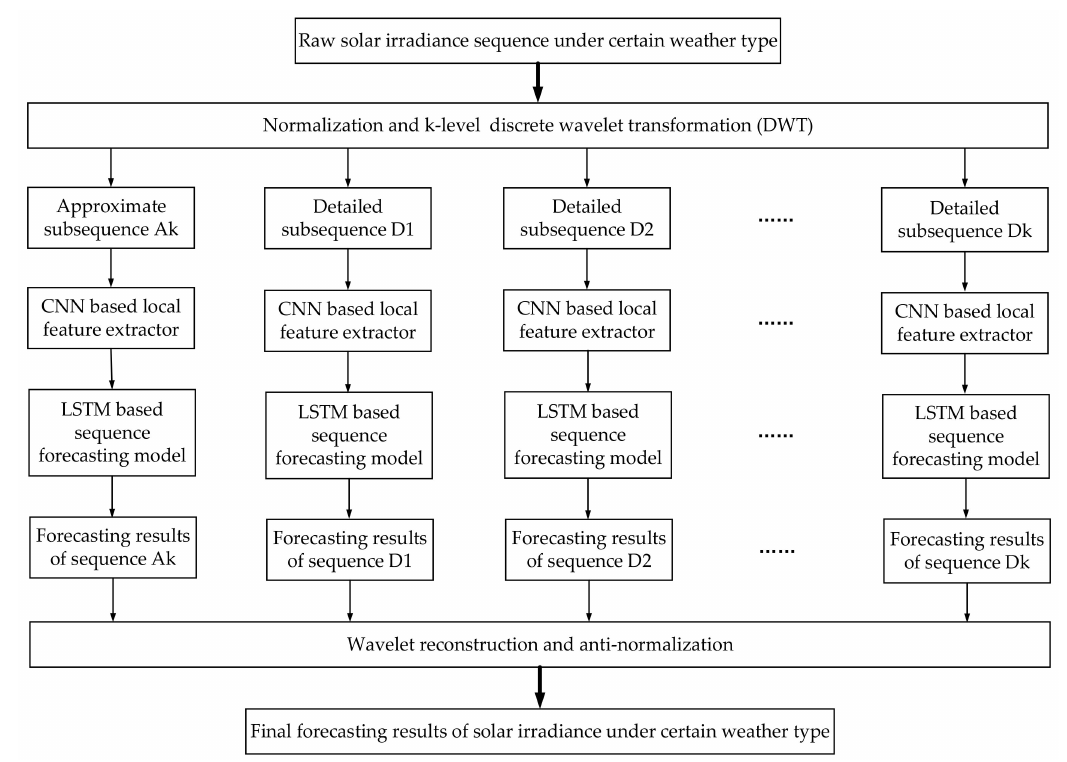
Figure 2. The detailed framework of DWT-CNN-LSTM day-ahead forecasting model for solar irradiance under certain weather type. The DWT-CNN-LSTM forecasting model is based on discrete wavelet transformation (DWT), convolutional neural network (CNN) and long short term memory (LSTM)